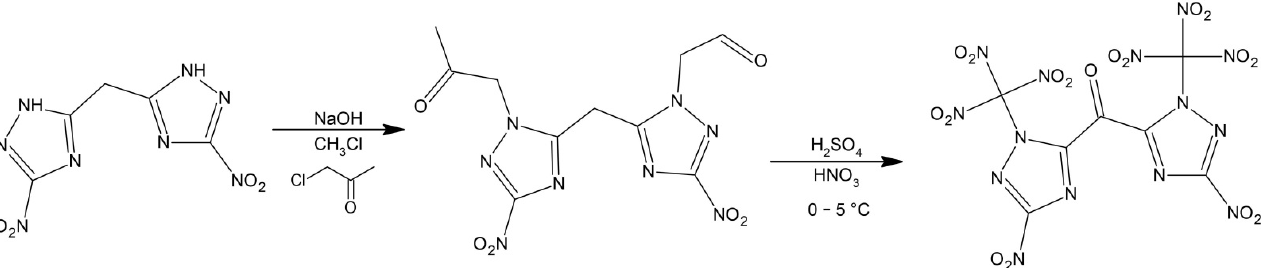
Figure 10. Synthesis of bis(3-nitro-1-(trinitromethyl)-1H-1,2,4-triazol-5-yl)methanone. Reprinted (adapted) with permission from [57]. Copyright 2021, American Chemical Society.